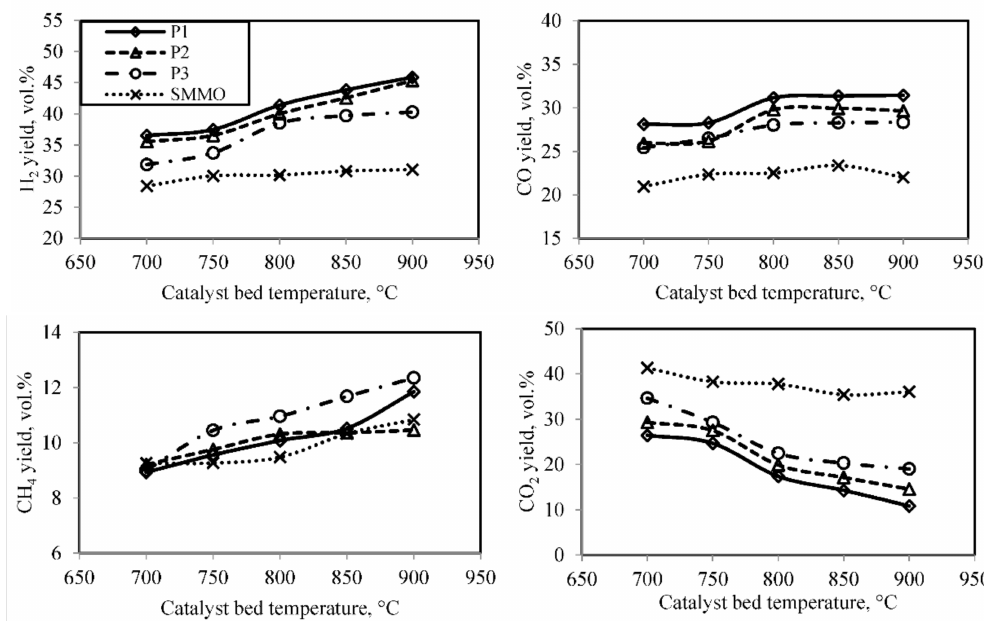
Figure 4. Effect of different catalyst to biomass (C/B) ratio on syngas product